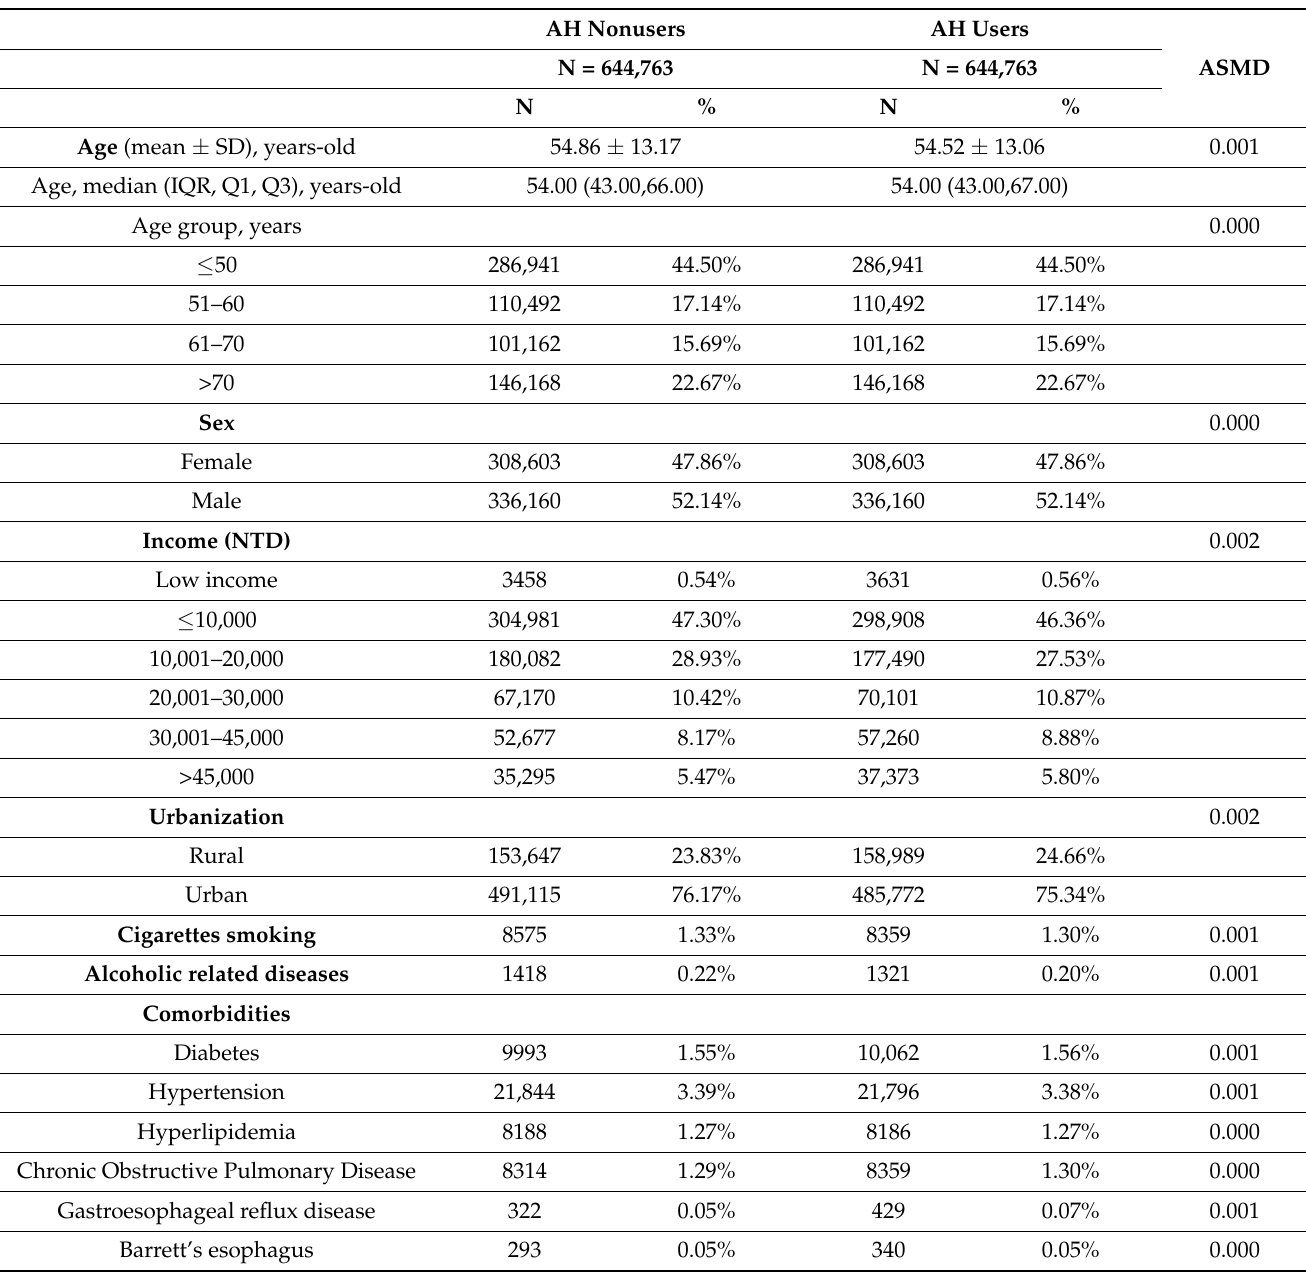
Table 1. Baseline Characteristics of AH User and Nonusers after